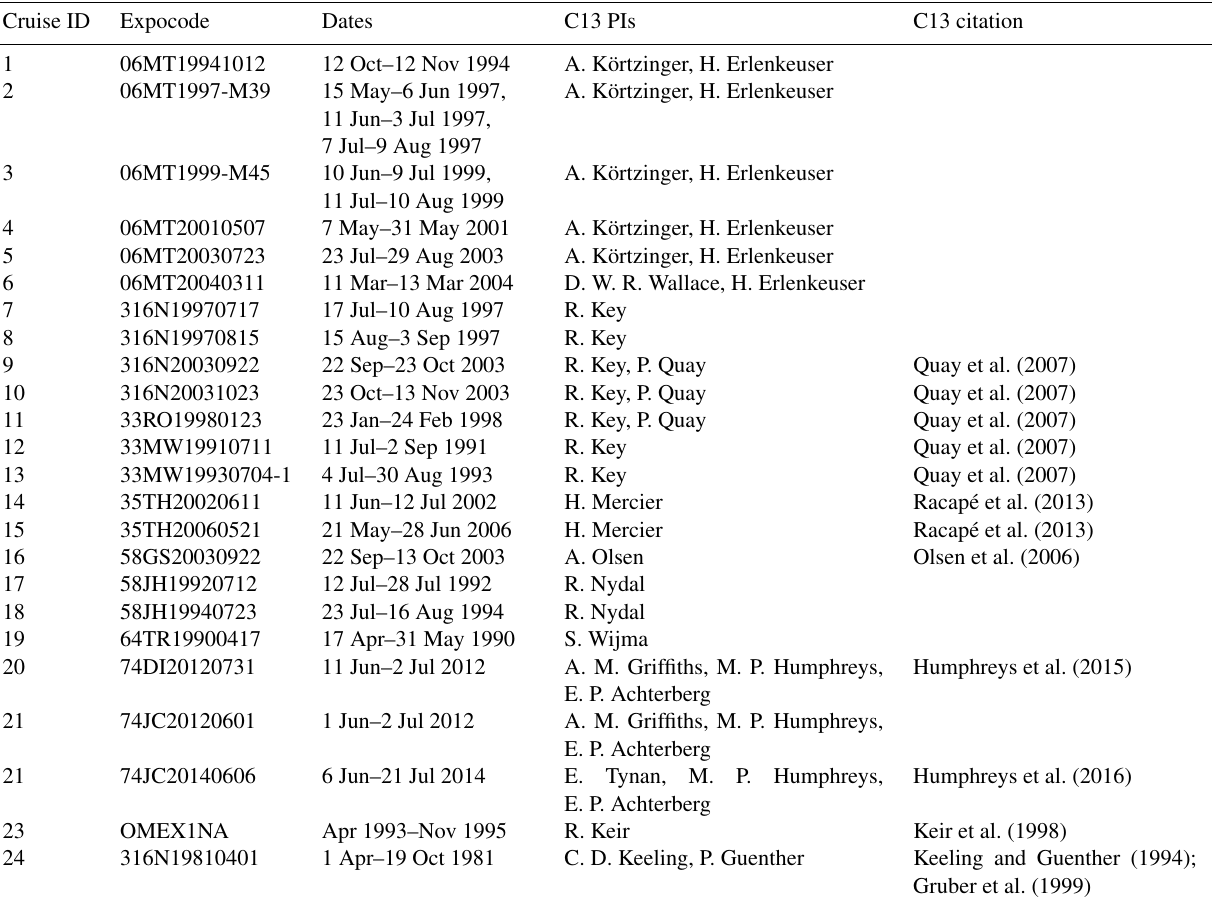
Table 1. Information about dates, PIs, and publications of each